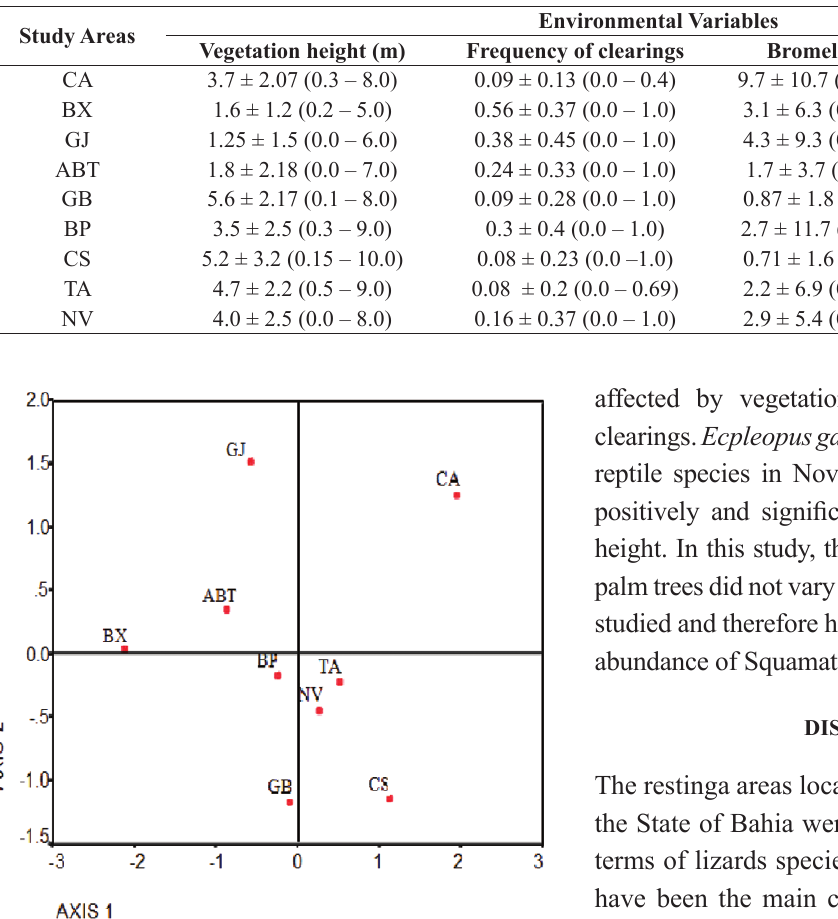
Fig. 6 - Multidimensional Scaling (MDS) comparing the attributes, frequency of occurrence of bromeliads and palm trees, vegetation height and frequency of clearings between the nine restinga ecosystems studied on the coast of the State of Bahia, Brazil: CA = Costa Azul; BX= Baixio; GJ= Guarajuba; ABT= Abaeté; GB= Guaibim; BP= Boipeba; CS= Cassange; TA= Taipe; NV= Nova